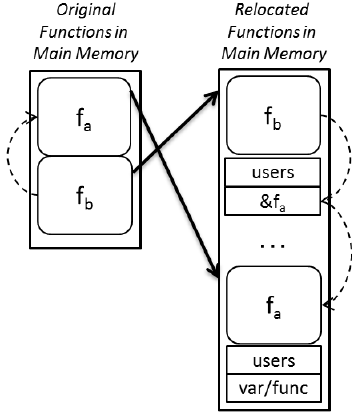
Figure 1. Schematic of code